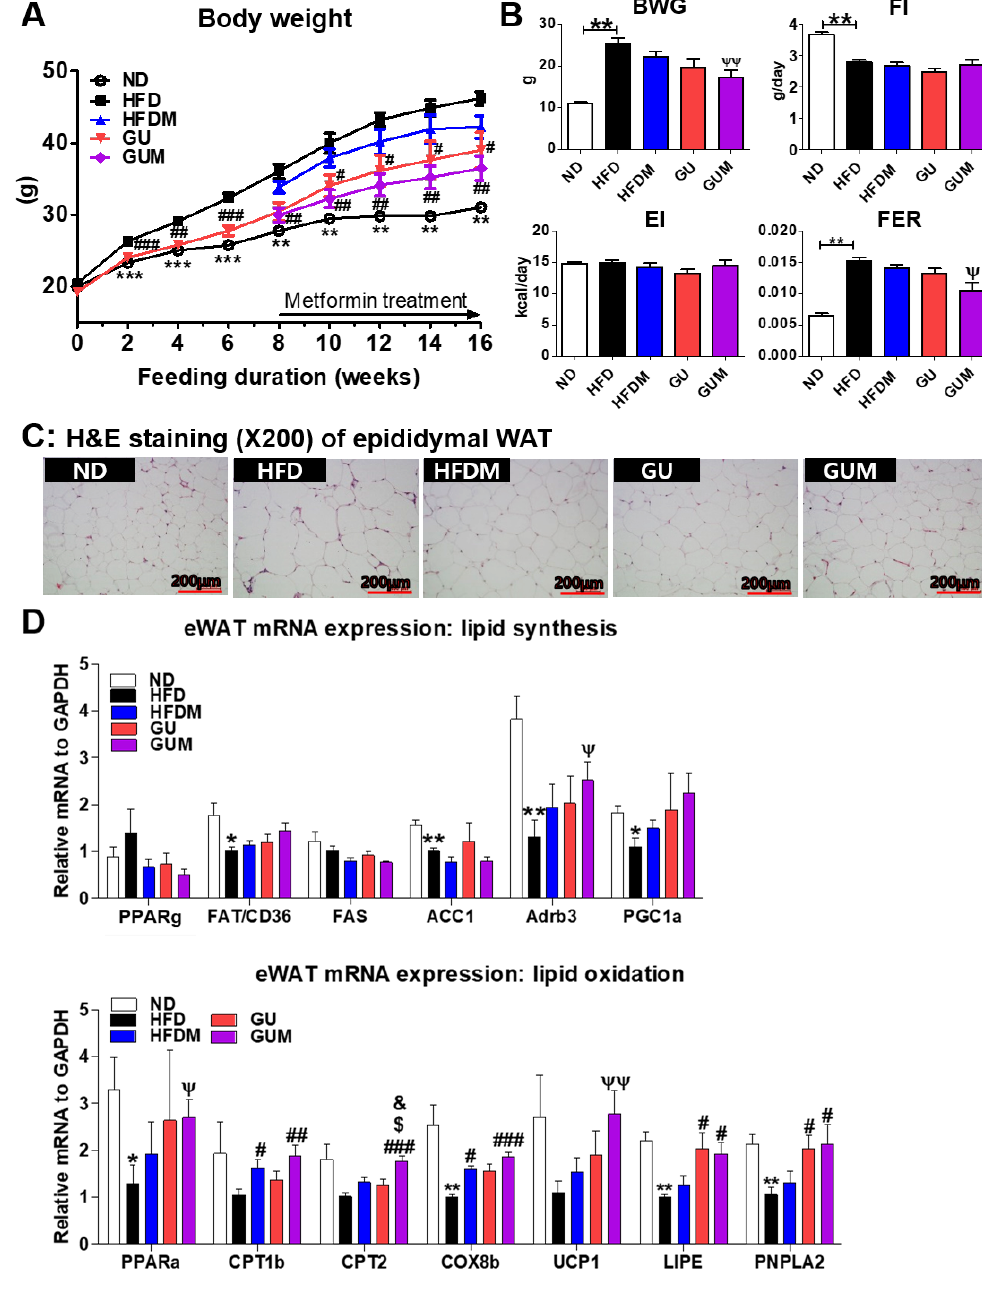
Figure 2. Effect of metformin, G. uralensis Fischer, and their combination after 16 weeks on body weight ( A ); body weight gain, food intake, energy intake, and food efficiency ratio ( B ); adipose tissue morphology (magnification 200 × ) ( C ); and epididymal WAT (eWAT) lipid-regulating gene expression ( D ) in C57BL/6J mice fed a high-fat diet (HFD). Data are presented as the mean ± SEM. Significant differences between HFD and ND are indicated: * p < 0.5, ** p < 0.01, *** p < 0.01. Significant differences among the high-fat diet groups are indicated: # p < 0.05, ## p < 0.01, ### p < 0.001. Significant differences between GUM and HFDM are indicated: $ p < 0.05. Significant differences between GUM and GU are indicated: & p < 0.05. When compared one-to-one, there were significant differences between GUM and HFD groups (Ψ p < 0.05, ΨΨ p < 0.01). ND, normal diet (AIN-93G 16 kcal% fat); HFD, high-fat diet (60 kcal% fat); HFDM, HFD + 50 mg/kg metformin; GU, HFD + 0.015% G. uralensis Fischer 0.015%; GUM, HFD + 0.015% G. uralensis Fischer + 50 mg/kg metformin.